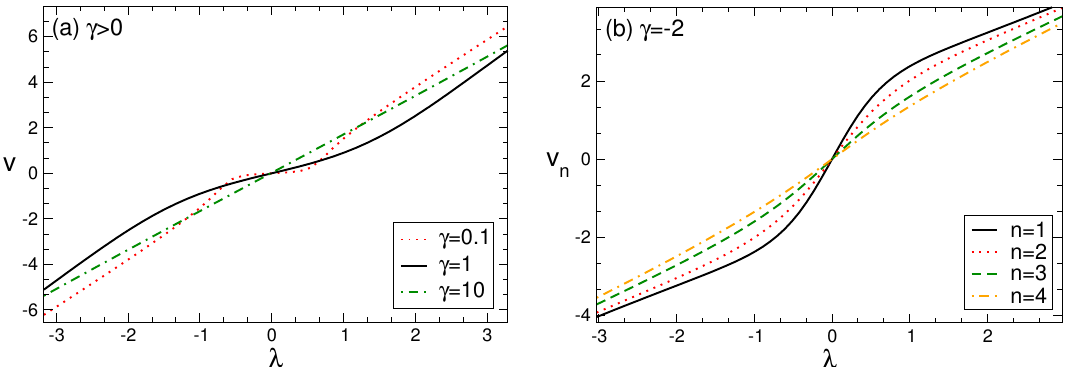
Figure 10: Group velocities of the low-lying excitations around the steady-state after the quench from the Bose condensate (BEC) in the Lieb-Liniger model. Panel (a). Results for the repulsive Lieb-Liniger. The different curves are the group velocities v plotted as a function of the rapidity λ for several values of the interaction strength γ . Panel (b) reports the group velocities for the attractive Lieb-Liniger model with γ = − 2. The different curves are for the different bound states. Notice that in both cases, the velocities are unbounded and grow linearly as λ → ±∞